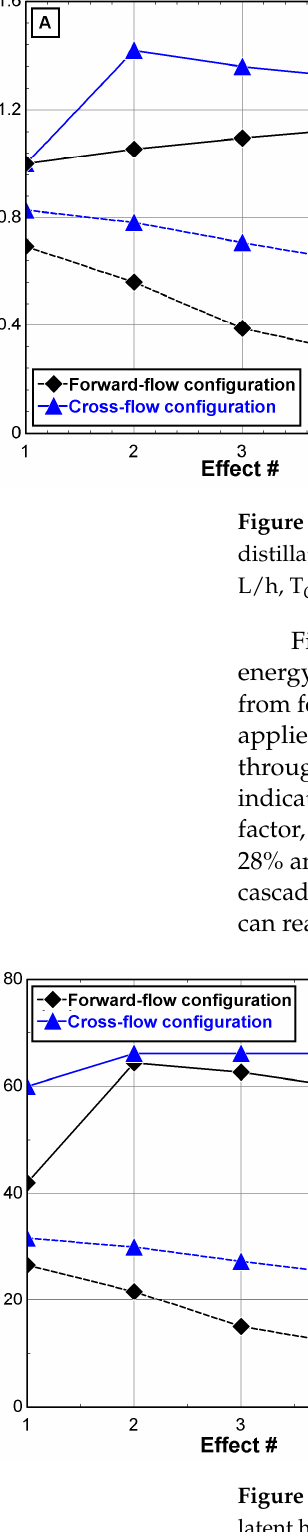
Figure 8. Internal performance indicators of the V-MEMD unit. ( A ) Feed water temperature and latent heat, ( B ) gain output ratio and heat recovery factor ( . latent heat, ( B ) gain output ratio and heat recovery factor ( 𝑣(cid:4662) (cid:3009)(cid:2869) = 900 l/h, T (cid:3009)(cid:2869) = 75 °C, 𝑣(cid:4662) (cid:3004)(cid:2869) = 405 l/h, v F 3 = 159 L/h, C F 3 = 1260 ppm, and P v = 11.5 T C 1 = 20 ◦ C, T (cid:3004)(cid:2869) = 20 °C, 𝑣(cid:4662) (cid:3007)(cid:2871) = 159 l/h, 𝐶 (cid:3007)(cid:2871) = 1260 ppm, and 𝑃 (cid:3049) = 11.5 kPa).